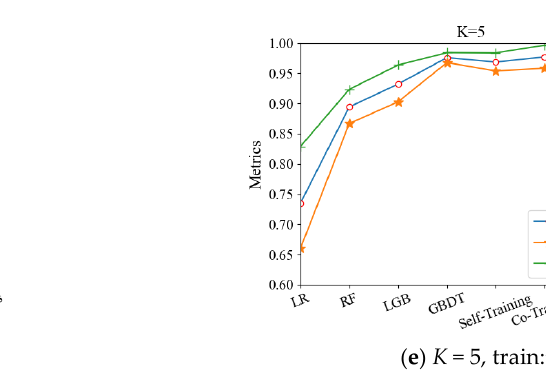
Figure 6. The evaluation metrics for each model: ( a – e ) the metrics obtained on the edX dataset with different models, which were tested under the different K-fold cross-validation and the different proportional divisions. Blue: F 1; orange: Precision ; green: Recall . Table 3. Comparison of the results of various models on the Breast Cancer Wisconsin Dataset. K-Fold